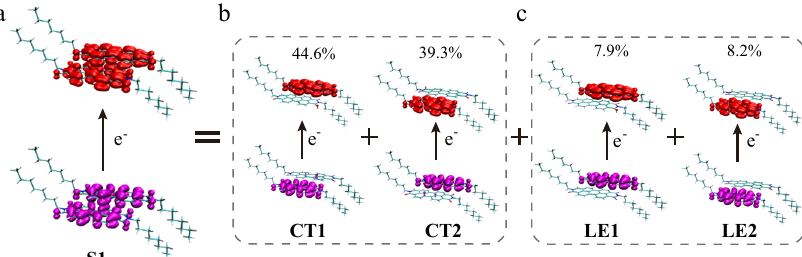
Fig. 1 Attachment – detachment densities of the S1 state and its composition of PTCDI-C8 dimer inside the crystalline structure. a Attachment densities are shown in red and detachment densities are shown in magenta. b , c The four transition components are recognized and quanti fi ed via Boys localized diabatization method, intermolecular charge-transfer ( b ); intramolecular charge-transfer (local excitation (LE) transition) ( c ). The two intermolecular charge-transfer (CT) transitions are the dominating of character the S1 state of PTCDI-C8 dimer inside the crystalline structure ( b ), which give rise to the broadened tailing peak in the